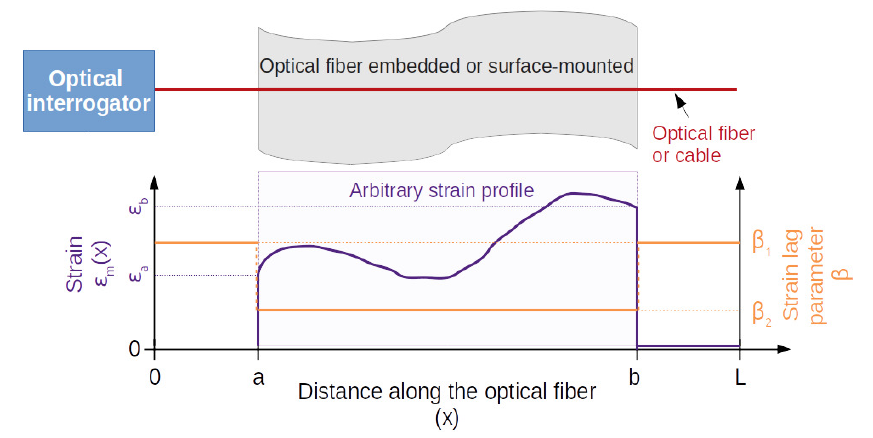
Figure 2. Arbitrary strain profile (cid:101) m ( x ) between the abscissas a and b along the optical fiber of length L